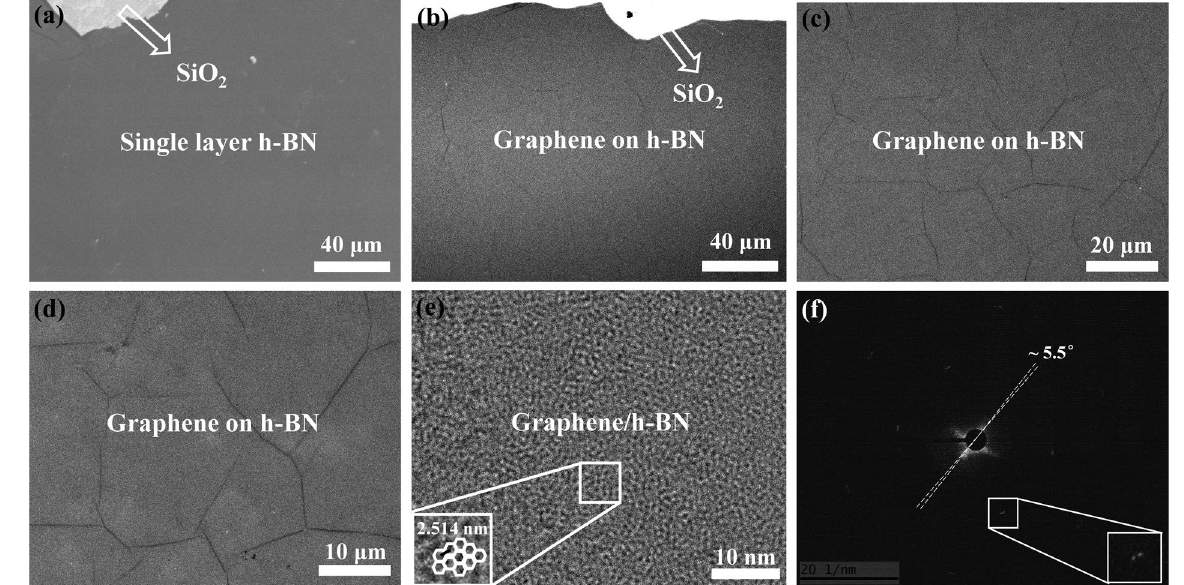
Figure 6. SEM and HR-TEM images of graphene on h-BN. ( a ) Single-layer h-BN. ( b ), ( c ), and ( d ), single-layer graphene on the h-BN film transferred onto a 300-nm-thick SiO 2 /Si substrate. ( e ) HR-TEM image of graphene/ h-BN heterostructure. ( f ) The SAED image of graphene/h-BN heterostructure.